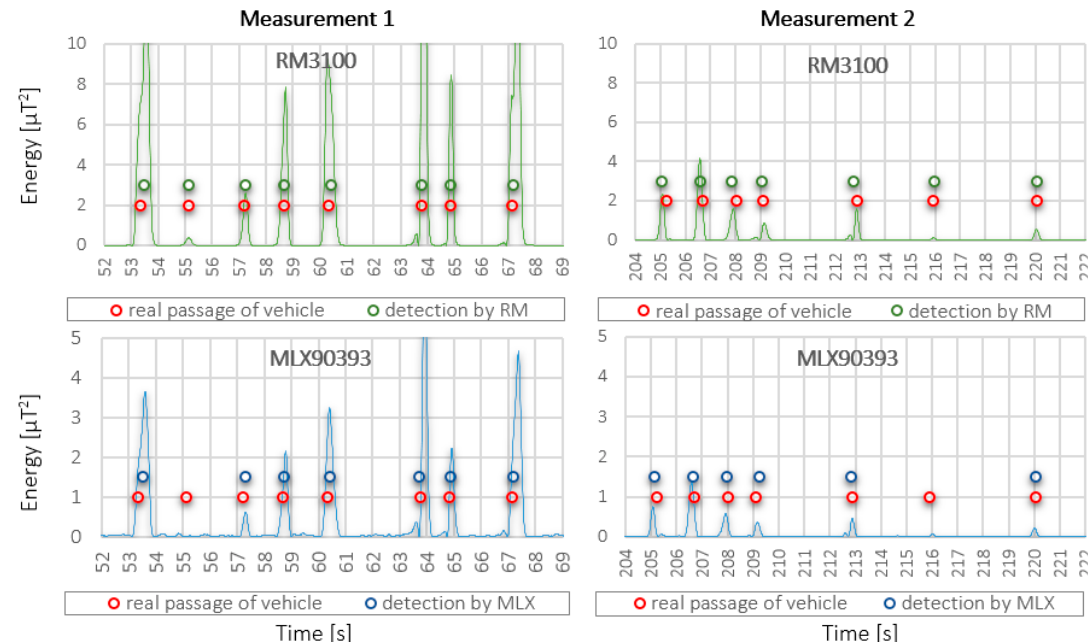
Figure 8. Comparison of the change of the input signal for detection at measurement 1 and measurement 2 for two selected sensors—RM3100 and MLX90393.